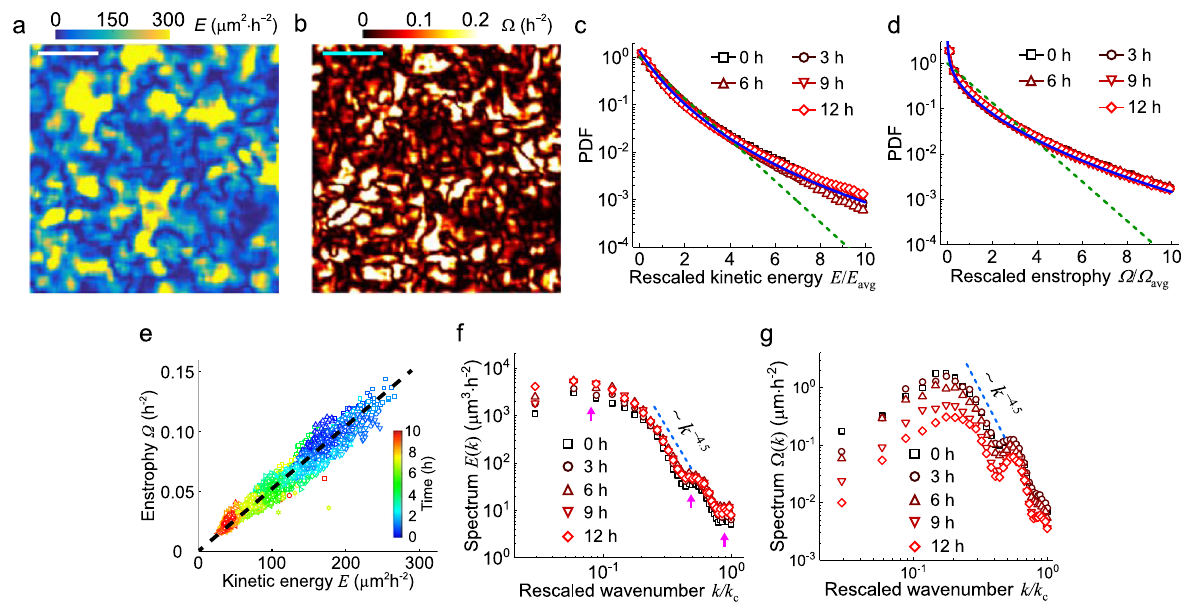
Fig. 2 Energetic statistics of mesoscale cell turbulence in Madin Darby canine kidney cell monolayers. a , b Representative fi elds of a the kinetic energy and b the enstrophy at t = 1 h with the approximate cell density 1 : 5 ´ 10 5 cm (cid:1) 2 . Scale bars, 300 µ m. c , d Probability density functions (PDFs) of c the rescaled kinetic energy and d the rescaled enstrophy. Data shown here are from one typical fi eld of view (FOV); different symbols correspond to different time points. The green dashed curves represent the Maxwell – Boltzmann distribution, while the blue solid curves refer to the fi ttings to q -Gaussian distributions (Eq. (2) for c and Eq. (4) for d ) with the Tsallis index q ¼ 1 : 2. The cell densities corresponding to time 0, 3, 6, 9, and 12 h are manually counted and estimated approximately as 1 : 4 ´ 10 5 cm (cid:1) 2 , 1 : 6 ´ 10 5 cm (cid:1) 2 , 1 : 9 ´ 10 5 cm (cid:1) 2 , 2 : 1 ´ 10 5 cm (cid:1) 2 , and 2 : 3 ´ 10 5 cm (cid:1) 2 , respectively. e The enstrophy Ω versus the kinetic energy E over time. Different symbols represent different data set (eight independent FOVs and four independent samples); the dash line refers to the fi tting Ω ¼ E = ξ 2 with the characteristic length scale ξ a (cid:3) 44 : 1 μ m and the correlation coef fi cient R 2 ¼ 0 : 952. f , g The energy spectra E ( K ) ( f ) and the a enstrophy spectrum Ω ( k ) ( g ) at different time points. The arrows indicate the plateaus. Here, k c represents the wavenumber at the scale of one